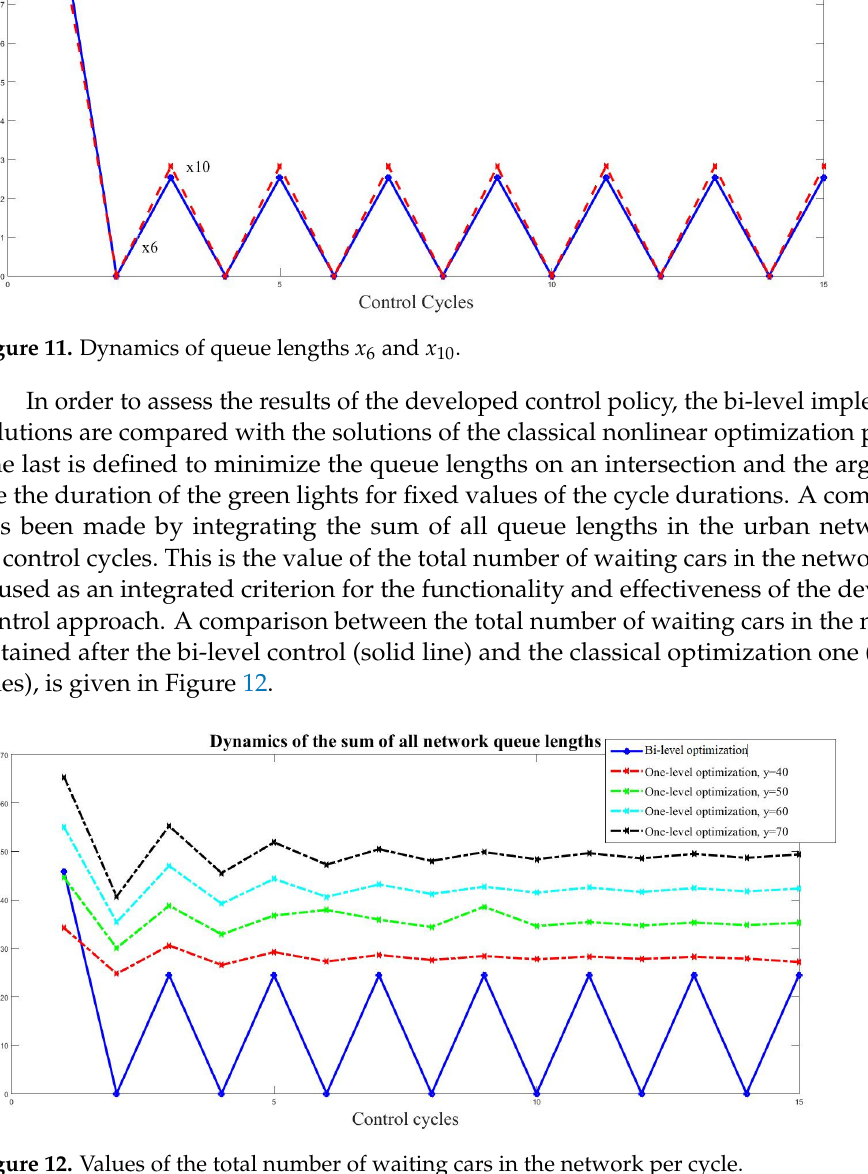
Figure 10. Difference between the evaluated and implemented green light duration u 14 .